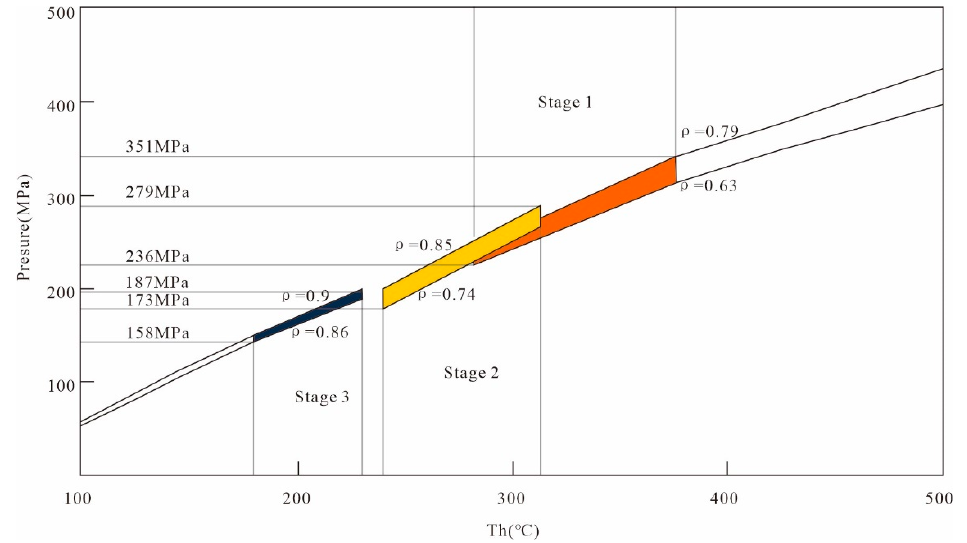
Figure 9. The estimated trapping-pressure–temperature diagram of the Reshui Mo deposit. Isochores of the fluid inclusions (FIs) are calculated using the Flincor software.